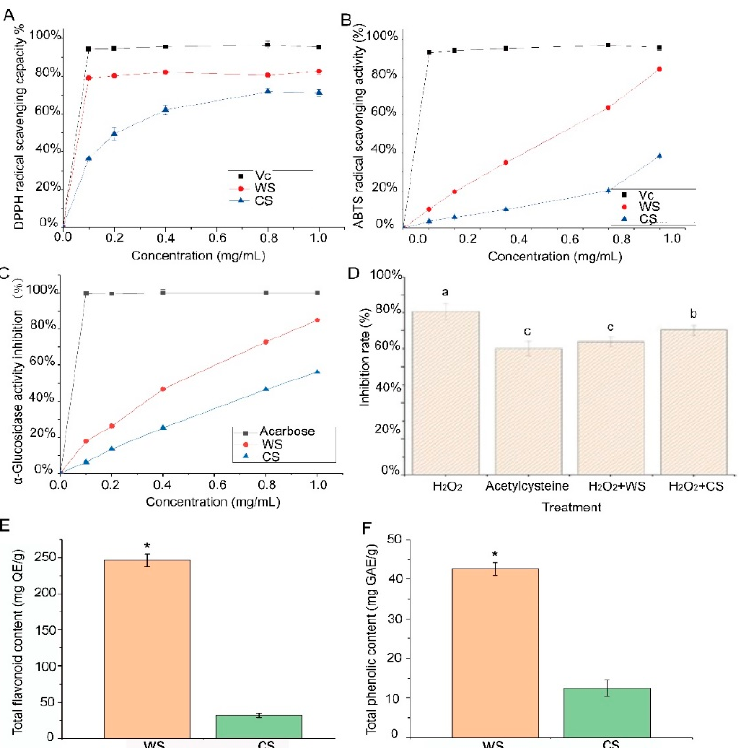
Figure 1. Biological activity and total phenolic and flavonoid content of wild soybean (WS) and cultivated soybean (CS). ( A ) DPPH radical scavenging activity; ( B ) ABTS radical scavenging activity; ( C ) α -glucosidase inhibitory activities; ( D ) inhibition rate after pre-incubation with WS and CS; ( E ) total flavonoid content of WS and CS; ( F ) total phenolic content of WS and CS. Each value represents means ± SD of triplicates. Statistical significance with an asterisks is according to p < 0.05.